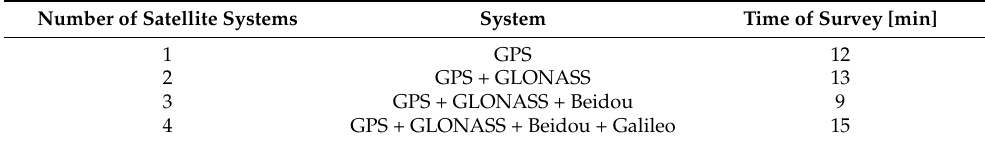
Table 4. Combination of GNSS systems.